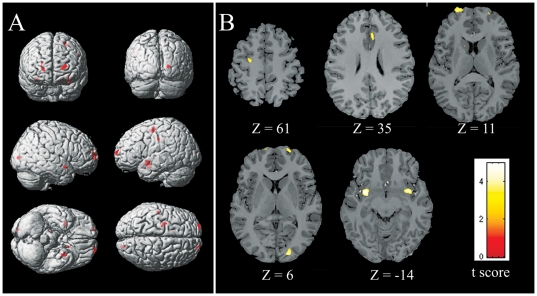
Gray matter volume decrease in HA residents vs. SL controls.(A) A statistical parametric map for gray matter reduced in HA residents compared with SL controls (B) Axial slice series depicting regions showing reduced gray matter volume in HA residents overlaid on Talairach template. Display threshold was set at |t|>2.70, p<0.01 (FWE corrected). Detailed coordinate and cluster size information of significant regions were shown in Table 3.